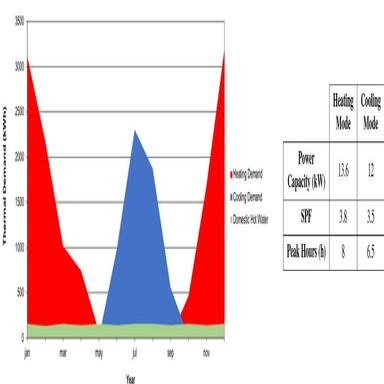
Thermal loads for a single house in a mild climatic region.